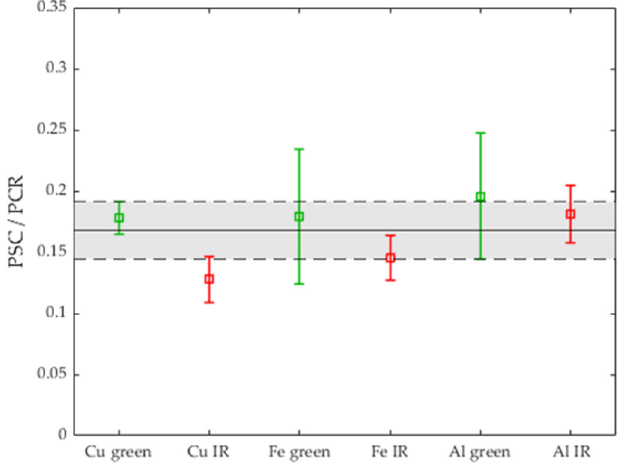
Figure 7. Ratio of the process stability criterion (PSC) over the phase change ratio (PCR) for the experimentally investigated metals copper, iron and aluminum and the two beam sources in the green ( λ = 515 nm) and IR ( λ = 1030 nm) wavelength regime. The grey indicates the range of the mean value of the ratio and its standard deviation (cid:4672) PSC = 0.178 ± 0.024 PCR